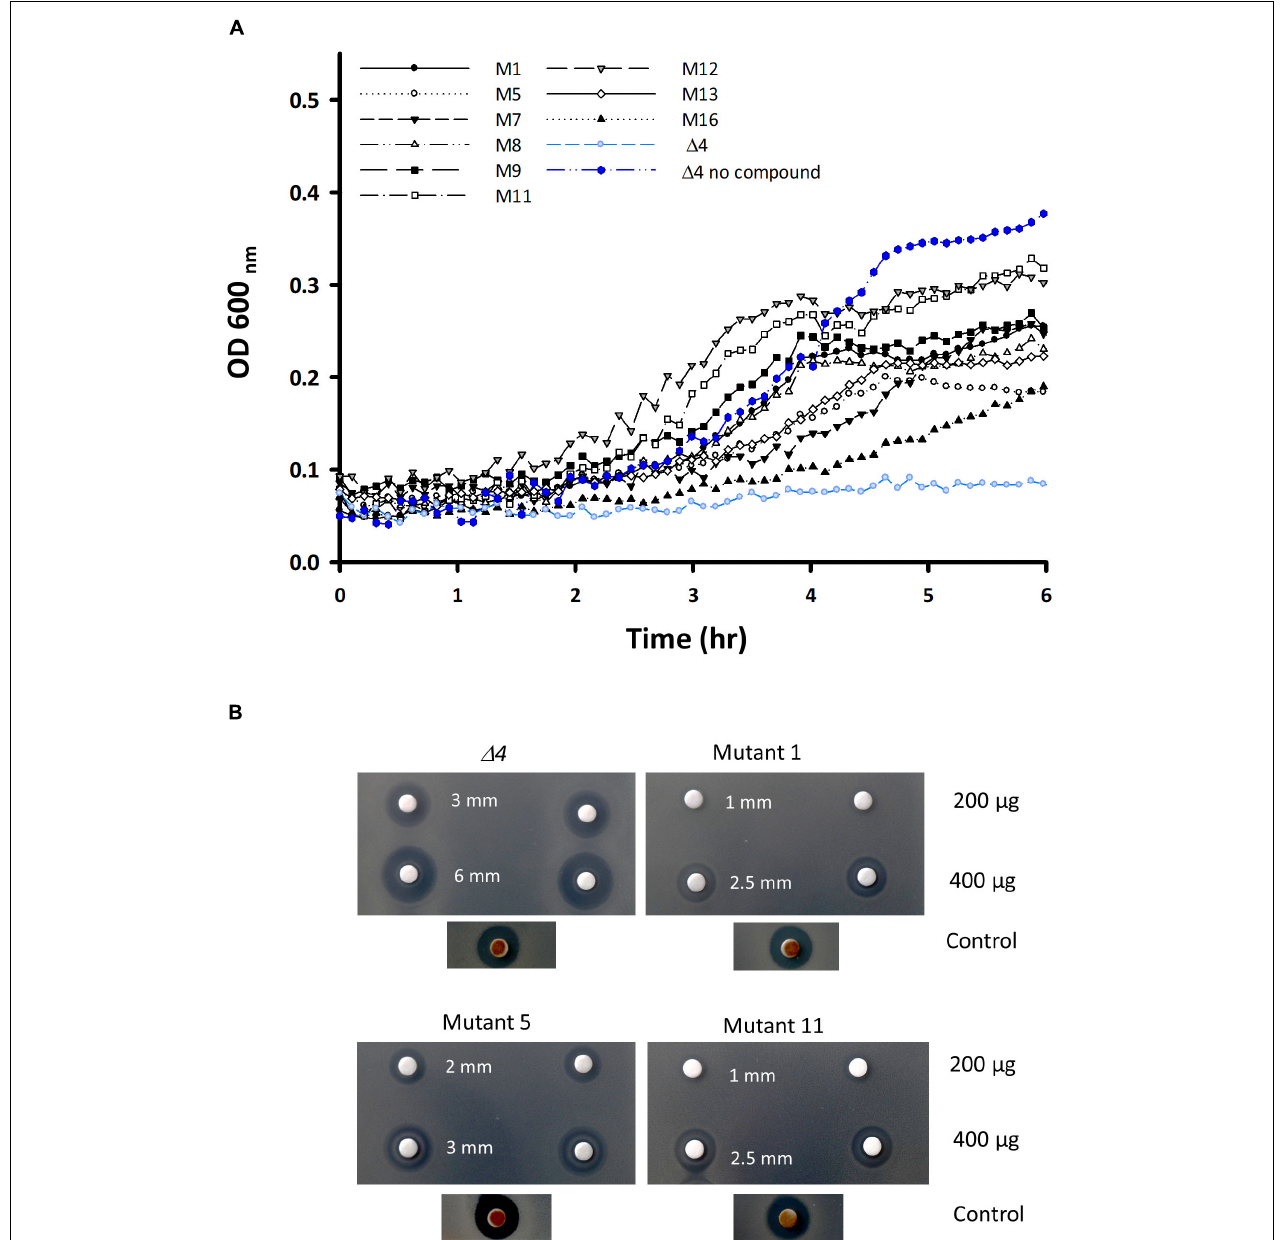
FIGURE 3 | Characterization of the mutants of the (cid:49) 4 strain resistant to IQC. (A) Growth curves of (cid:49) 4 , and various resistant mutants derived from (cid:49) 4 , in the presence of an inhibitory concentration of IQC (100 µ g ml − 1 ). (B) Disc diffusion assay comparing the sensitivities of the 3 main pyrG mutants (mutants # 1, 5, and 11) and the (cid:49) 4 parental strain to 200 and 400 µ g IQC in duplicate. The positive control disc contained 5 µ L of